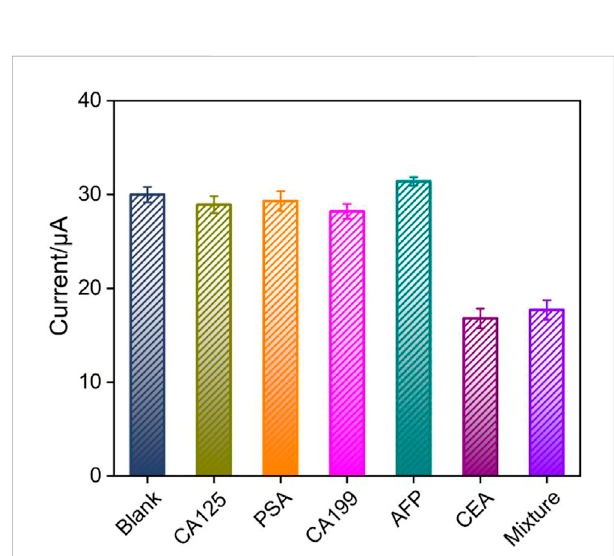
FIGURE 7 The peak current ( I ) obtained on the immunosensor in absence or presence of different interfering substances or their mixture. Error bars represent the RSD of three